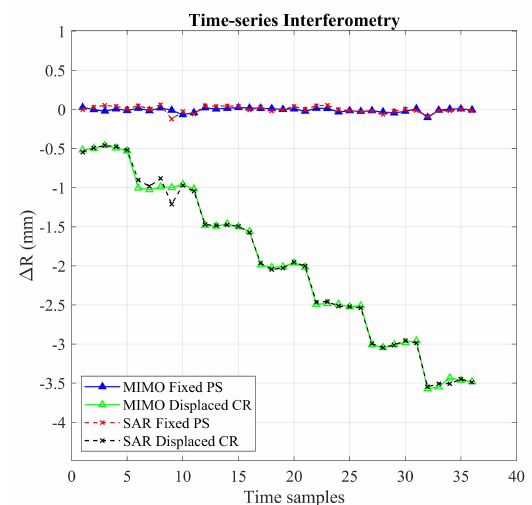
Figure 5. Time-series displacement measurements of deployed corner reflectors by MIMO radar and MIMO GBSAR signals.